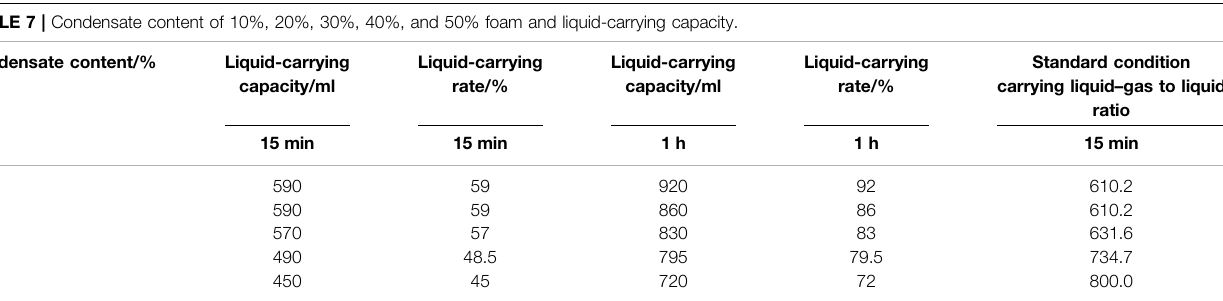
TABLE 7 | Condensate content of 10%, 20%, 30%, 40%, and 50% foam and liquid-carrying